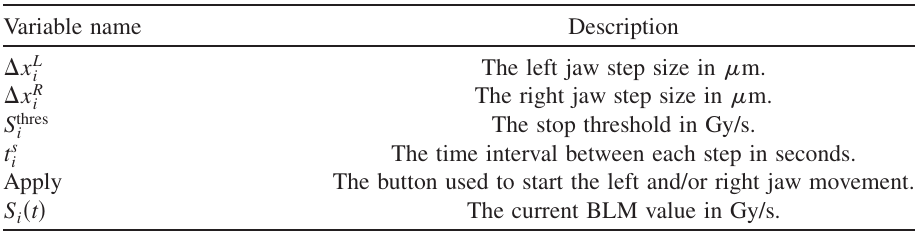
TABLE II. Overview of the variables used in the semiautomatic algorithm. Variable name Description